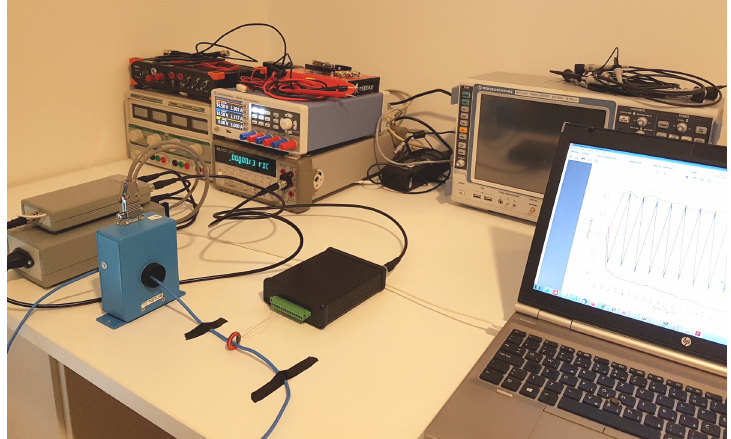
Figure 10. Test bench with 40A9R connected to the DC-CT evaluation controller, MACCplus 600A, HP334401A, RTO1004, NGE100, and HP66000A with the custom developed 2 MHz generator under